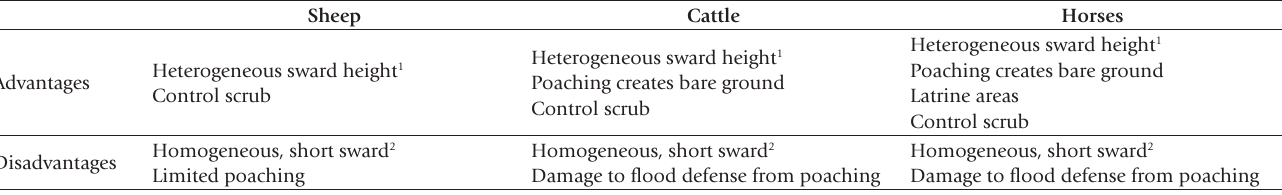
Table 4. Advantages and disadvantages of three different grazing animals for grassland Orthoptera conservation and maintaining flood defense